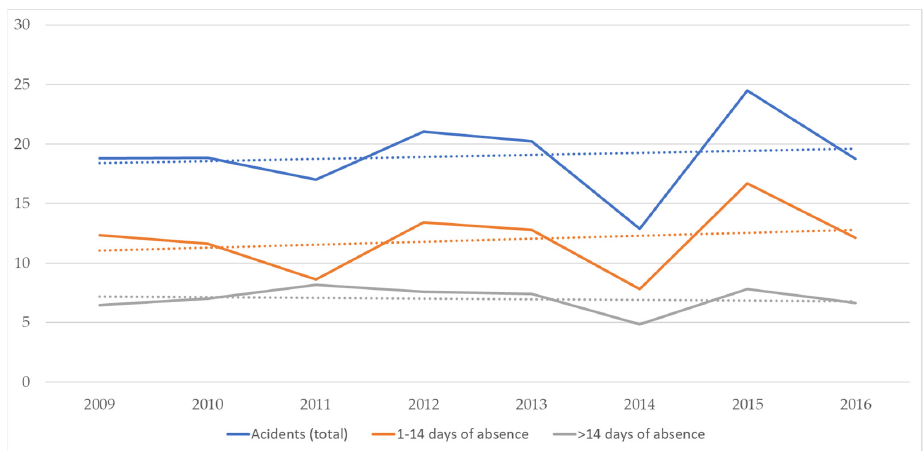
Figure 10 . Incidence rates in demolition. Based on data from [17 – 24,27] .